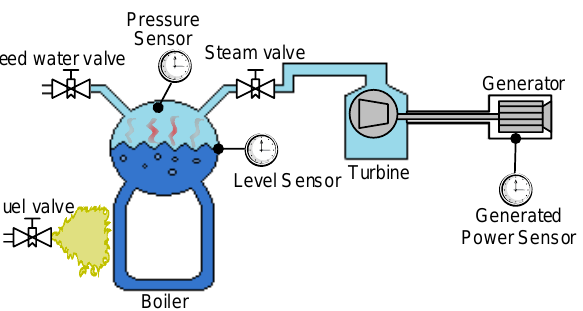
Figure 1. Example process of a boiling water power plant including control and measurement